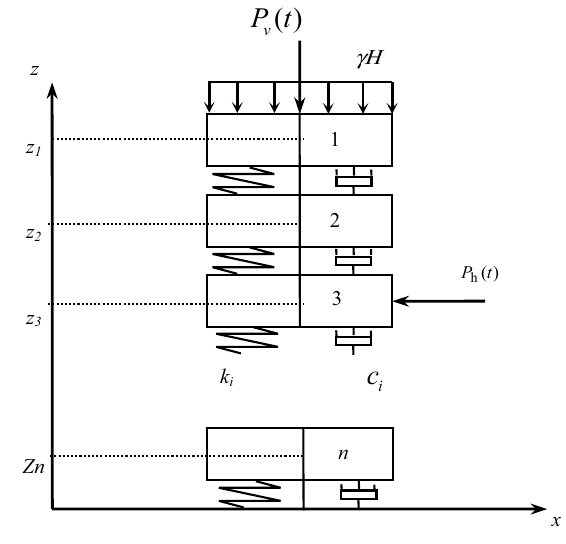
Fig. 1 Theoretical model of effect of ultra-low